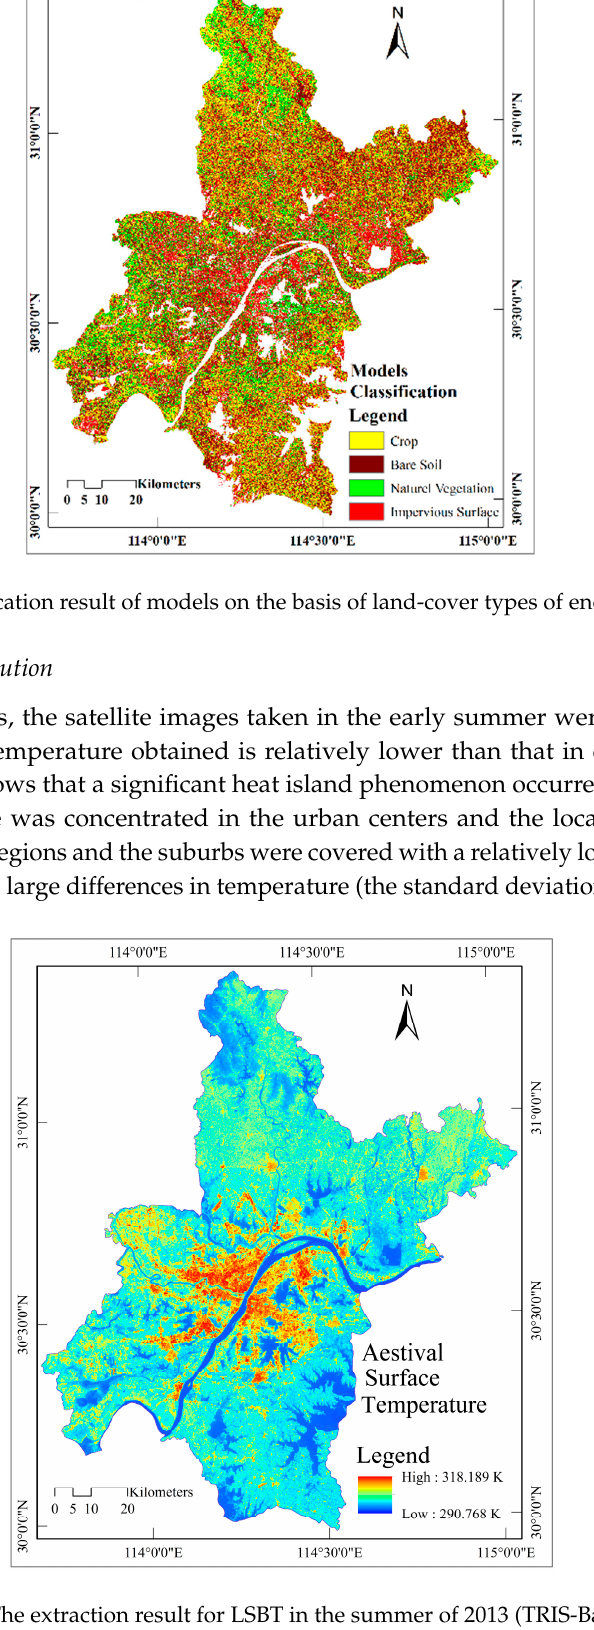
Figure 8. The extraction result for LSBT in the summer of 2013 (TRIS-Band 10).